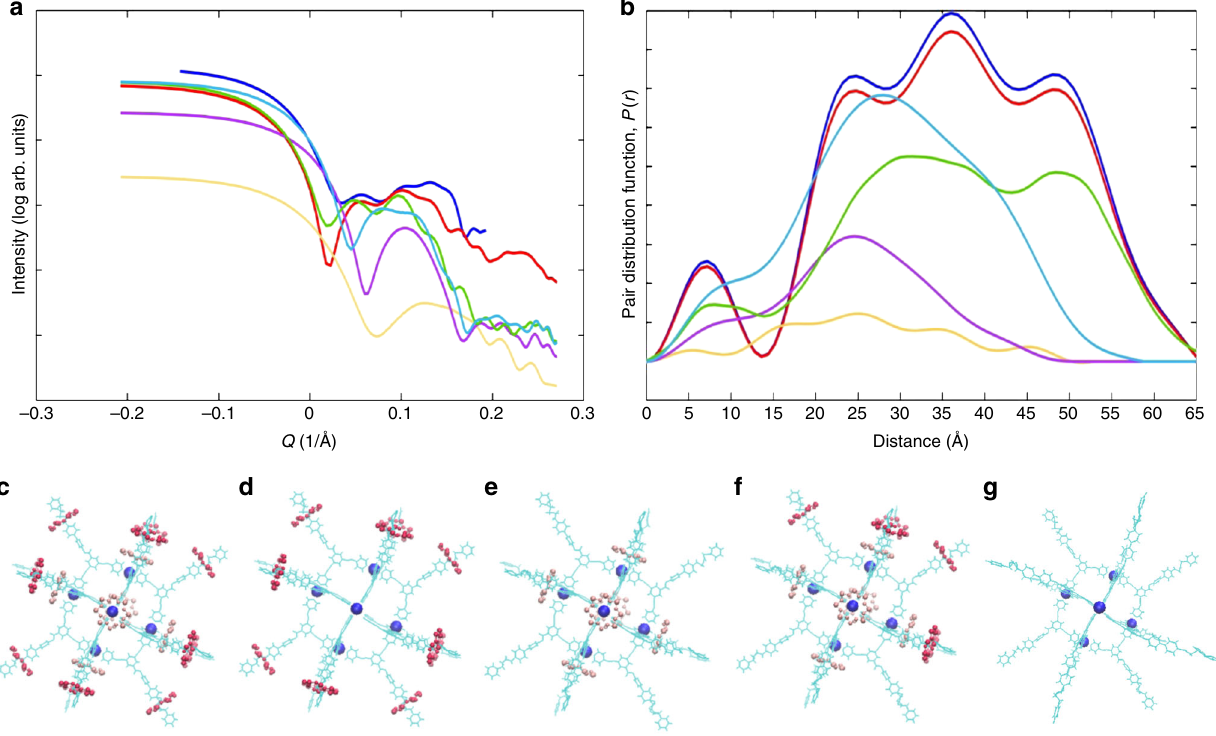
Fig. 3 Small-angle X-ray scattering (SAXS) for 3 dissolved in THF and models to interpret the SAXS. a SAXS data recorded as a 25 mM solution in THF at 298 K. b shows a pair distance distribution function. In a and b the experimental result is shown in blue. The calculated traces are: the whole structure of 3 (red, shown in c ); the structure lacking the six ring anions (green, shown in d ); the structure lacking the rings on the thread of the [2]rotaxanes (purple, shown in e ); the structure lacking half the rings from the rotaxanes (cyan blue shown in f ); the {Pd 6 } core and organic threads only (orange, shown in g